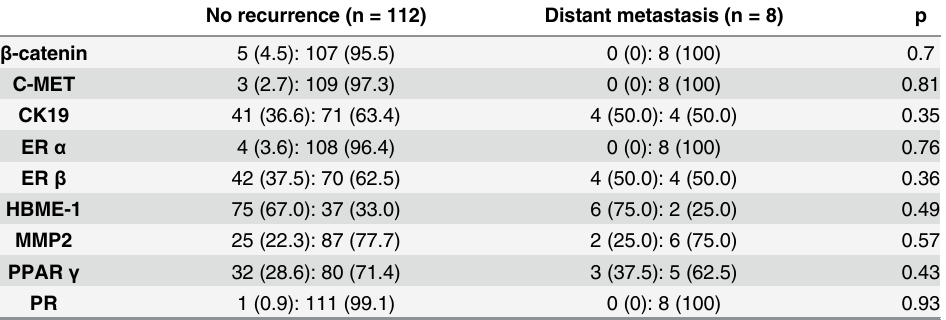
Table 4. Comparison of the expression of protein markers between the group with distant metastasis and without distant metastasis. No recurrence (n = 112)